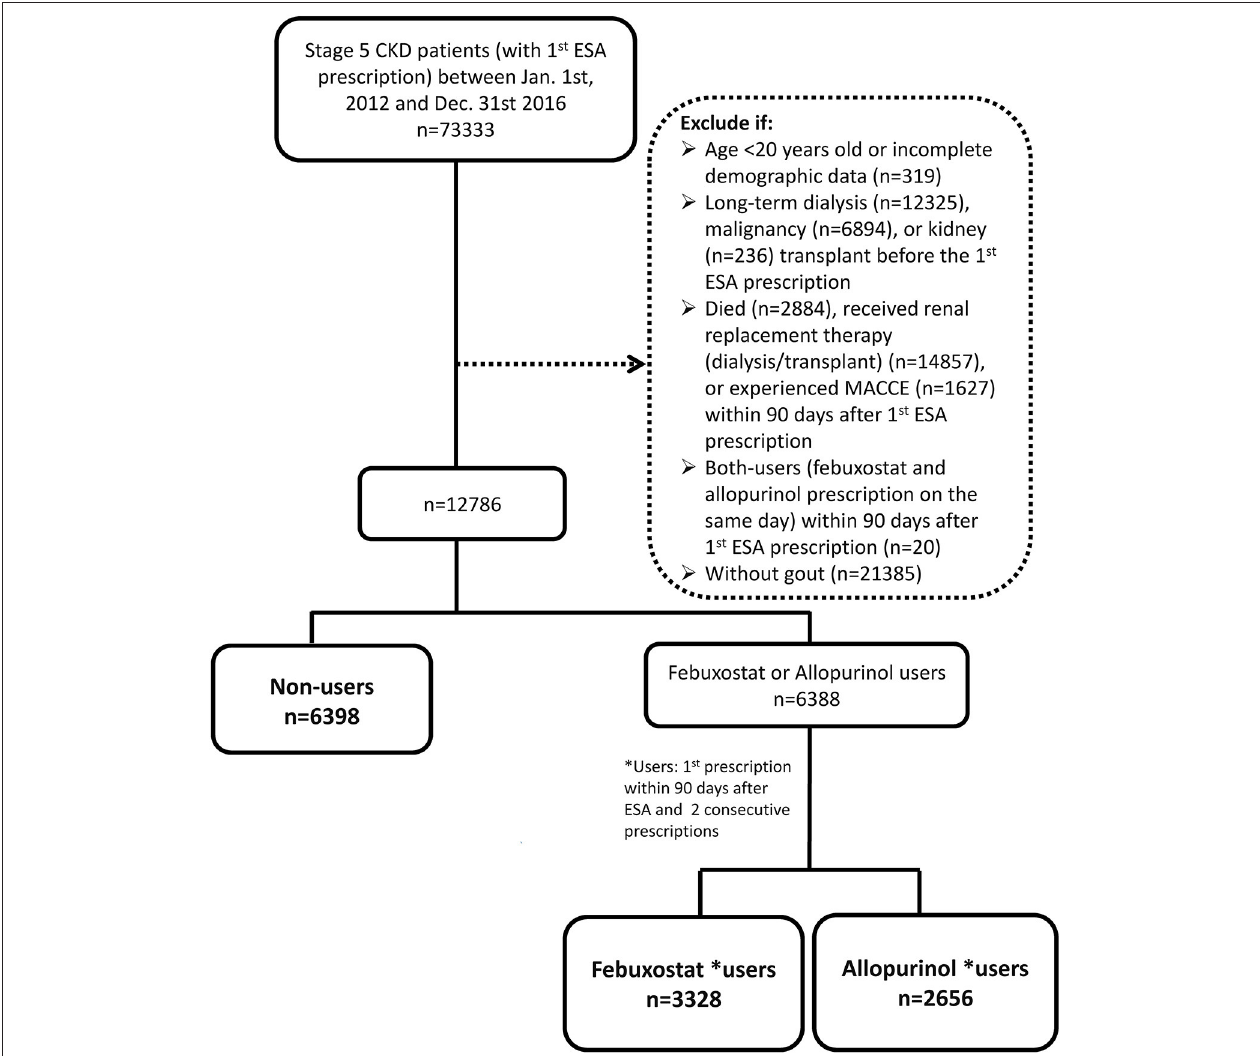
FIGURE 1 | Flowchart of patient